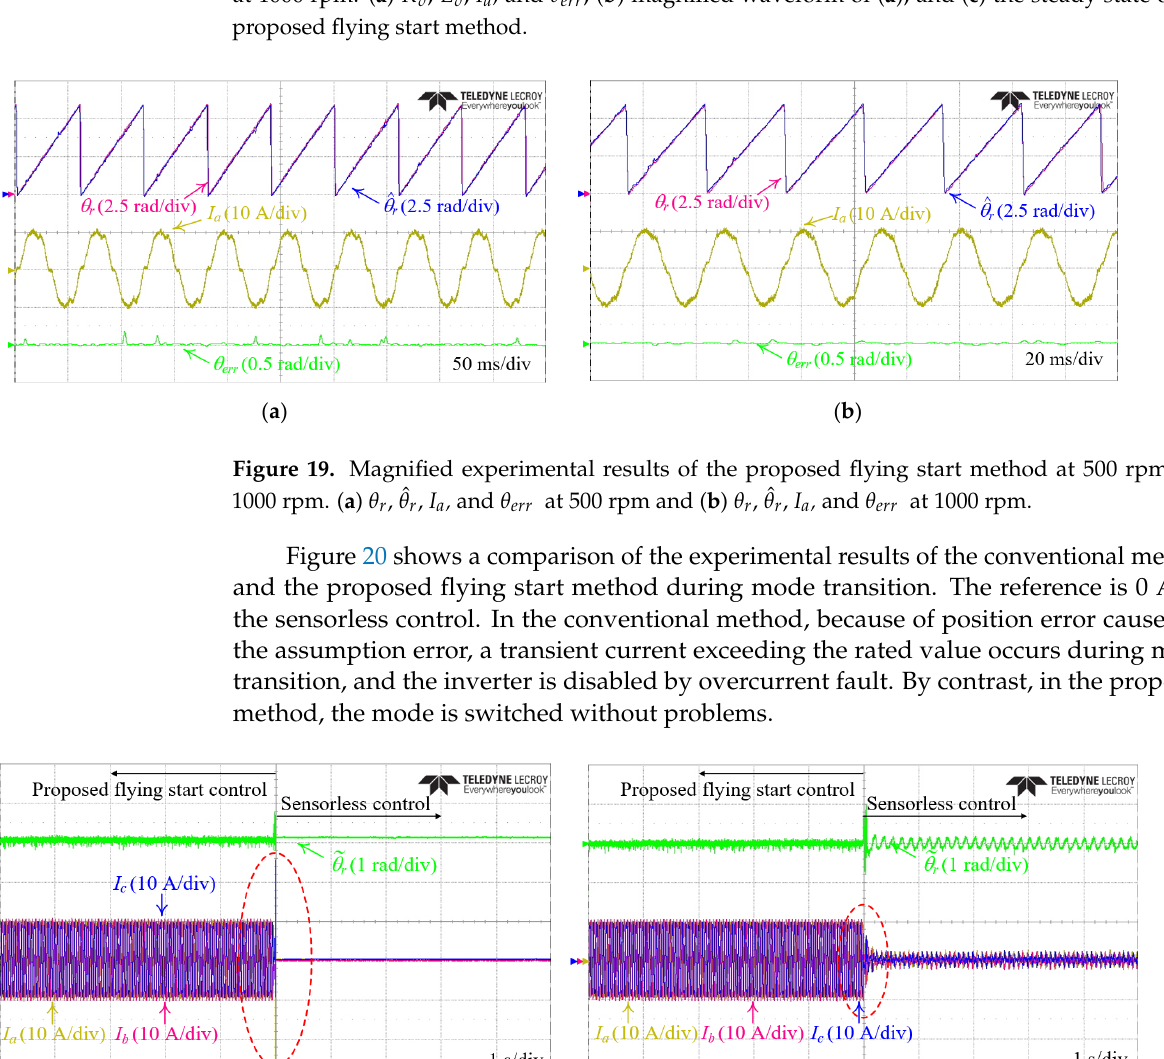
Figure 18. Experimental results of the proposed flying start method and its position estimation error at 1000 rpm. ( a ) R v , L v , I a , and θ err ; ( b ) magnified waveform of ( a ); and ( c ) the steady state of the proposed flying start method.